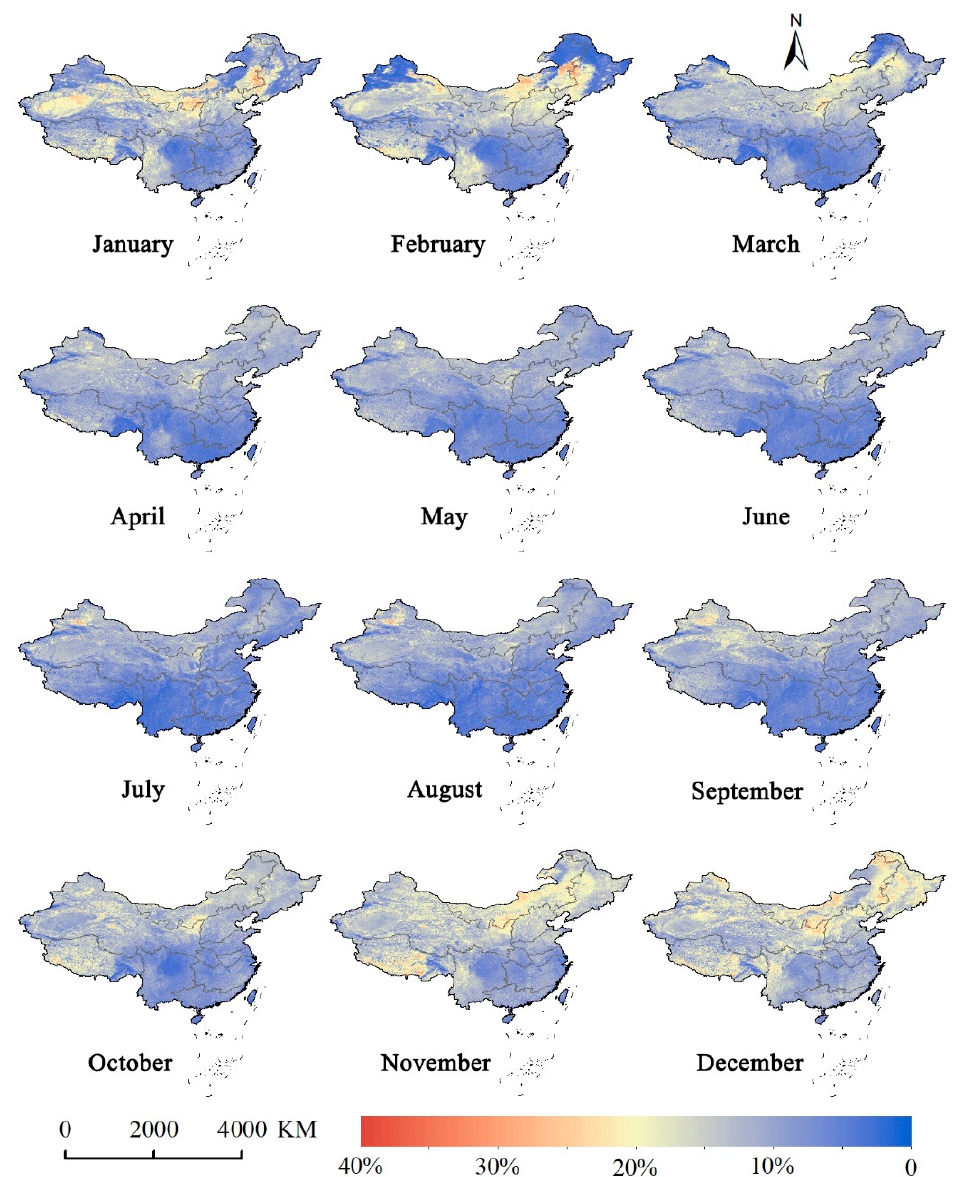
Figure 4. Standard deviations for the monthly probability of acquiring cloud-free imagery from 1990 to 2019.